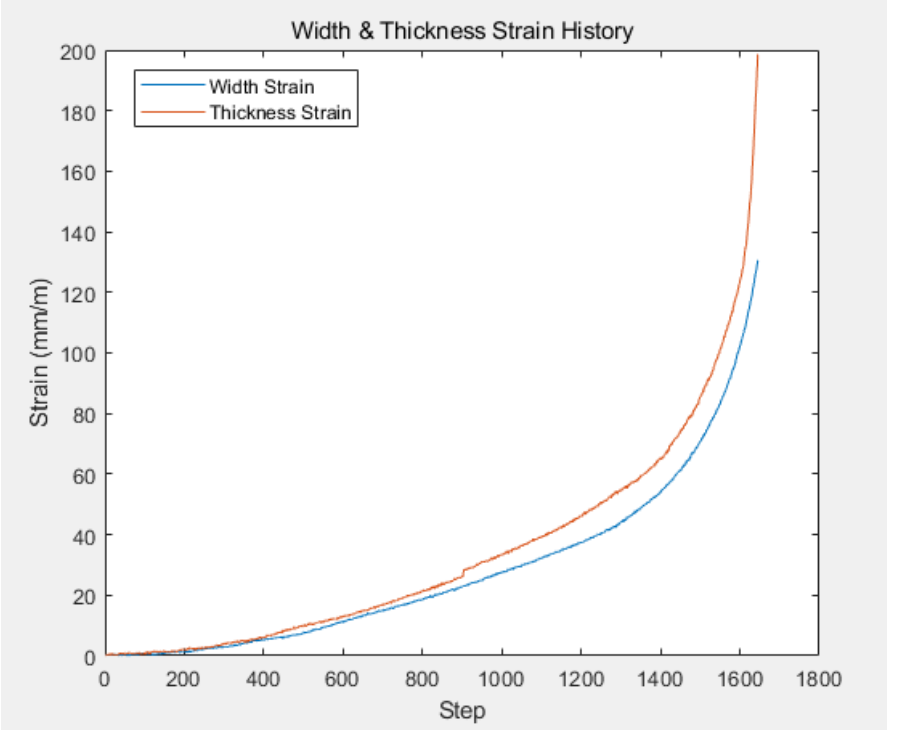
Figure 14. Width and Thickness strain history.